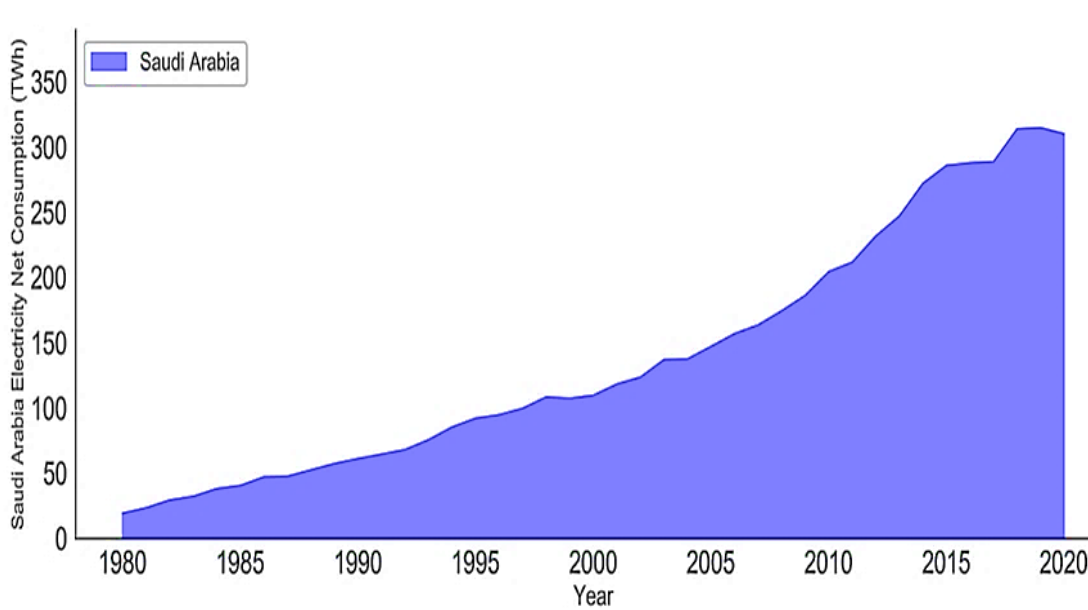
Figure 1. Historical levels of electricity generation in Saudi Arabia.